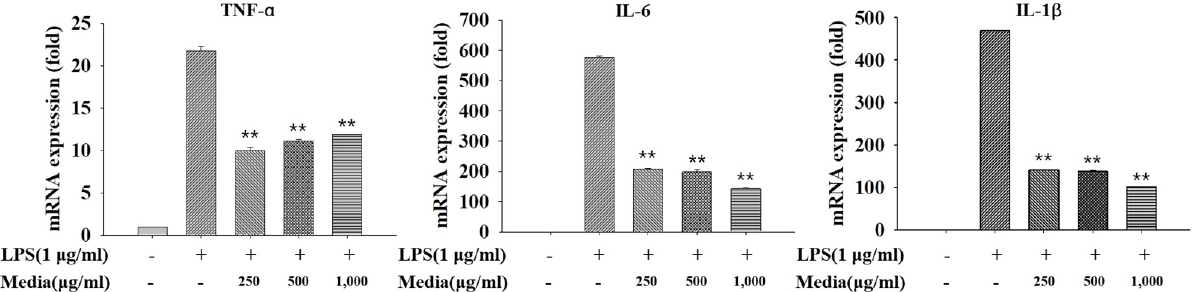
Figure 5. The mRNA expression levels of TNF- α , IL-1 β , and IL-6, stimulated by the treatment with L. fermentum KGC1601-cultured media in RAW 264.7 cells through qRT-PCR. Data are presented as the mean ± standard deviation of values obtained from triplicate experiments. ** p < 0.01 versus the LPS-treated group.